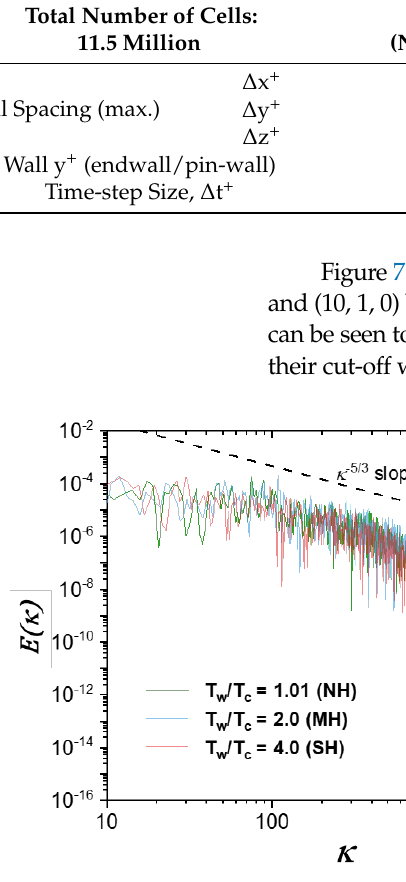
Figure 7. Energy Spectra obtained with different heating loads at x/D = 5 and 10.